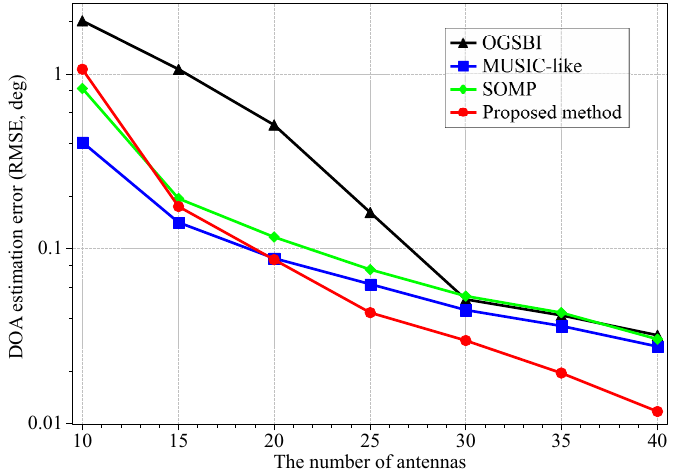
Figure 6. DOA estimation performance with different numbers of antennas.